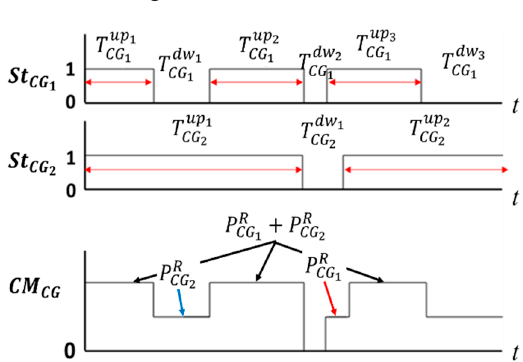
Figure 1. Two-state Model.